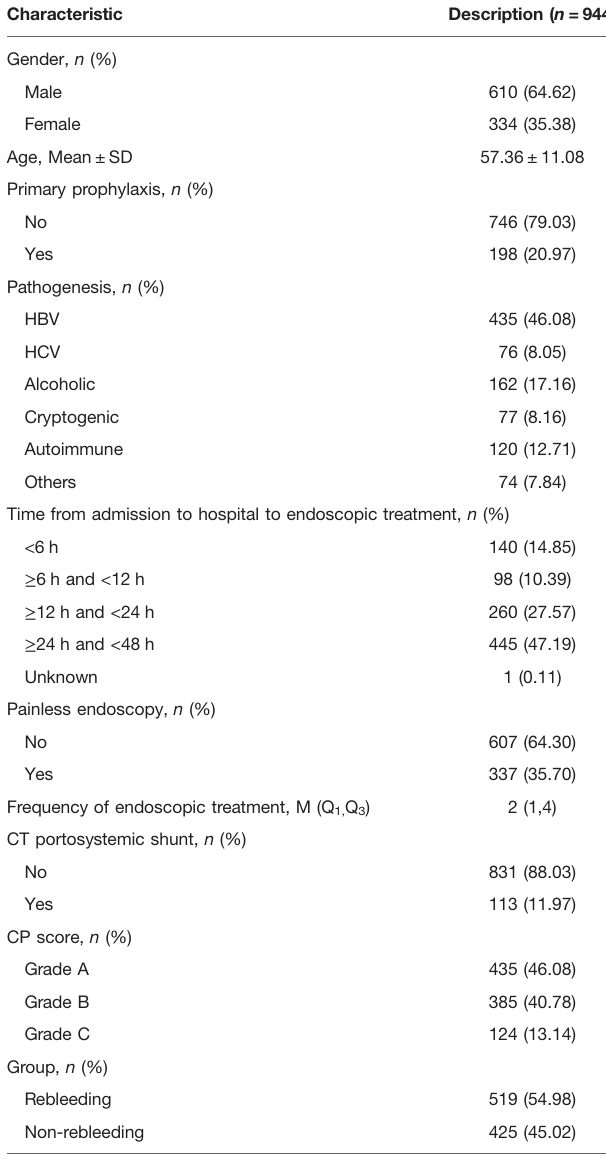
TABLE 1 | The baseline characteristics of all